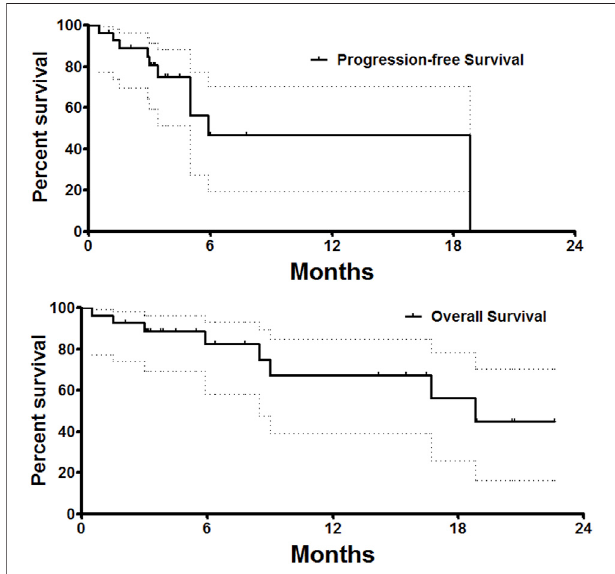
FIGURE 4 | Survival follow-up. The PFS was 5.9 months, and the median overall survival was 18.8